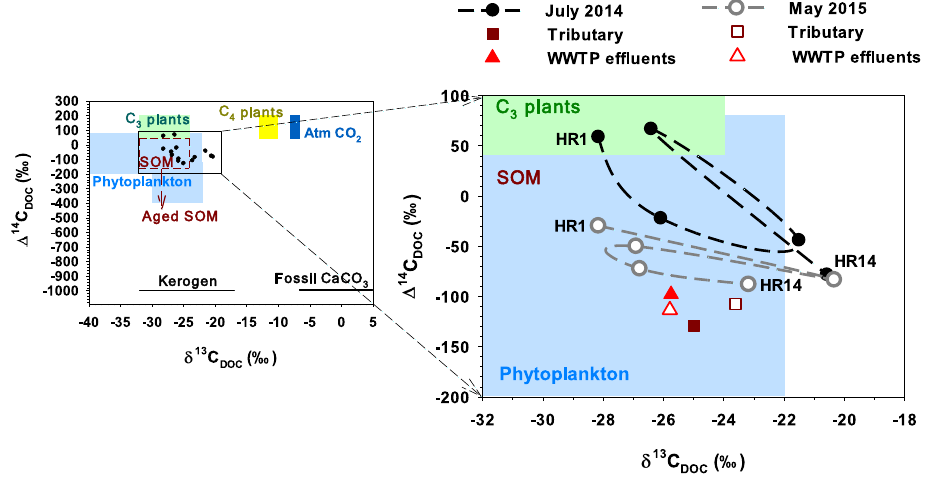
Figure 7. δ 13 C and (cid:49) 14 C in DOM sampled at five Han River main stem sites, an urban tributary, and a WWTP discharge. Main stem (HR1, HR4, HR8, HR11, and HR14) and tributary (HR12) samples were collected in July 2014 and May 2015, whereas two WWTP effluent samples were obtained in June 2014 and November 2015. Reference values for DOM sources presented on the left plot are from Marwick et al. (2015) and references